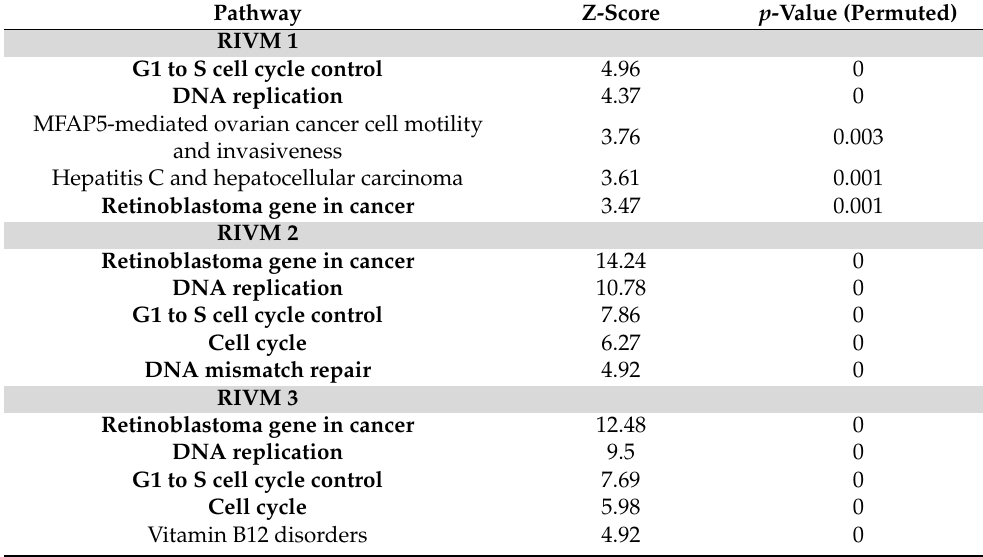
Table 5. Top 5 significant pathways for M0 macrophages derived from THP-1 cells exposed to RIVM 1, 2, and 3 preparations extracts. DEGs selected by moderated t -test with adjusted p -value < 0.2 were used for pathway analysis in PathVisio. Pathways related to cell cycle control are shown in